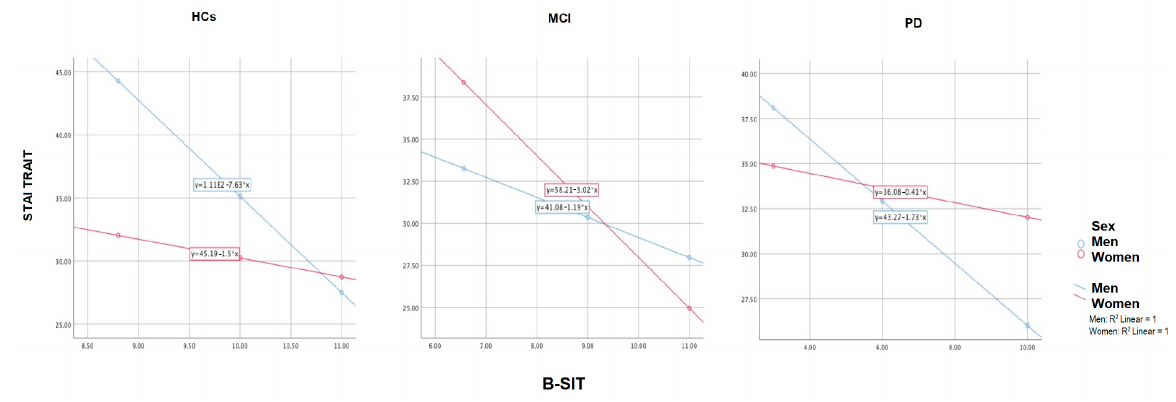
Figure 1. HC, MCI, PD partial regression plot of B-SIT*Sex interaction predicting STAI Traits (con- trolled for age and education).